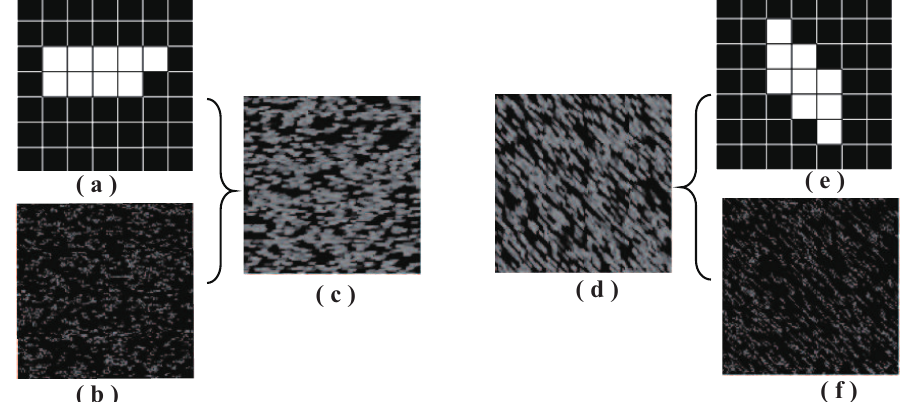
Figure 1. Synthesized textures. Texture 1 ( a ) grain and ( b ) skeleton and ( c ) Synthesized Texture 1; ( d ) Synthesized Texture 2 and Texture 2 ( e ) grain and ( f ) skeleton.